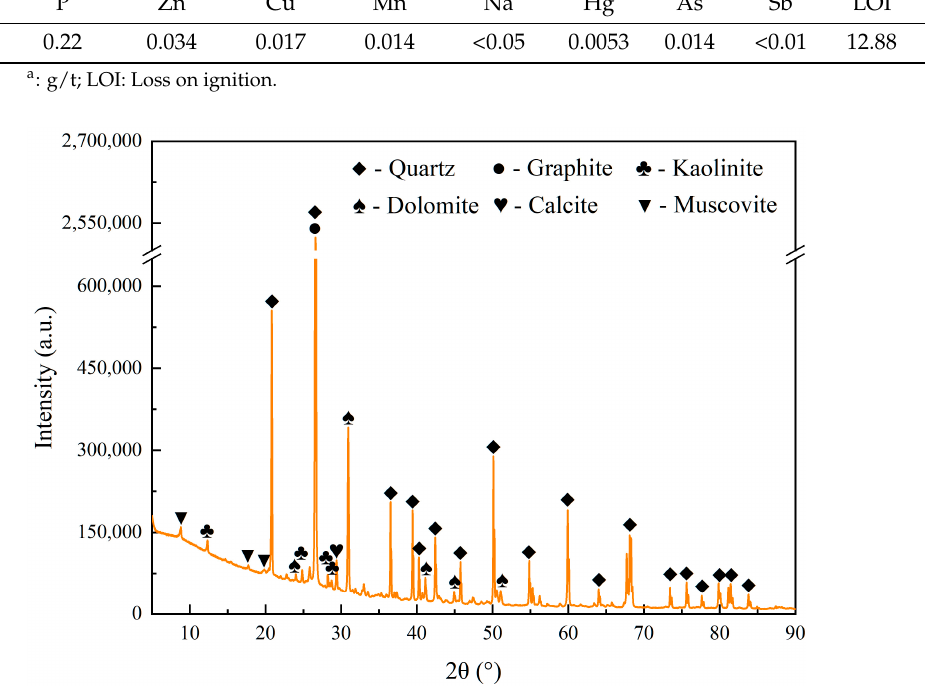
Figure 1. XRD pattern of the raw ore. Table 1. Chemical composition analysis results of the raw ore. Table 2. Gold chemical-phase analysis results of the raw ore.